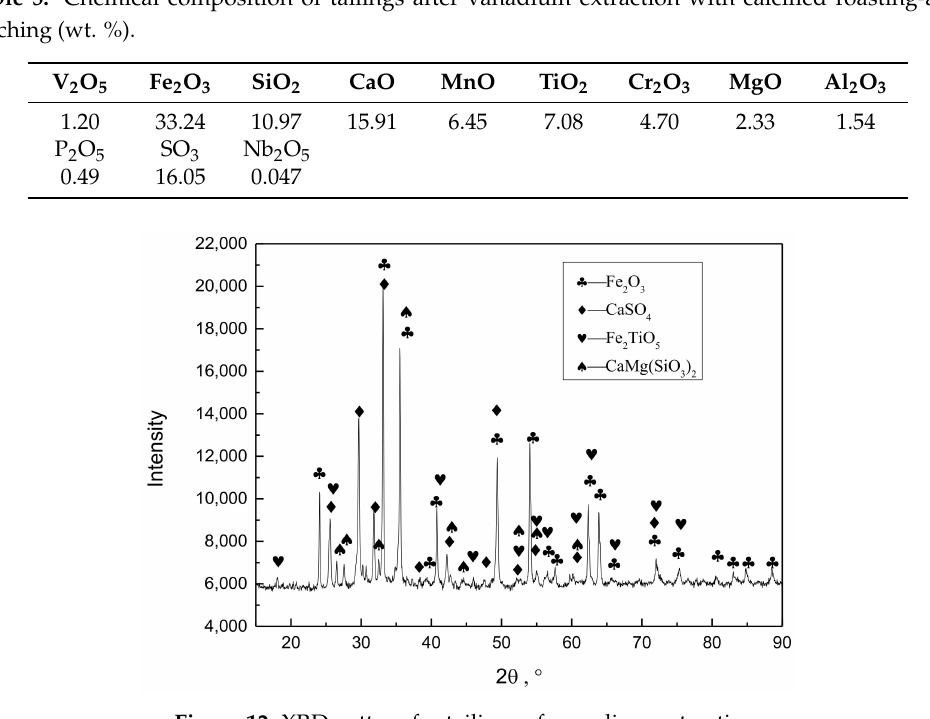
Figure 12. XRD pattern for tailings of vanadium